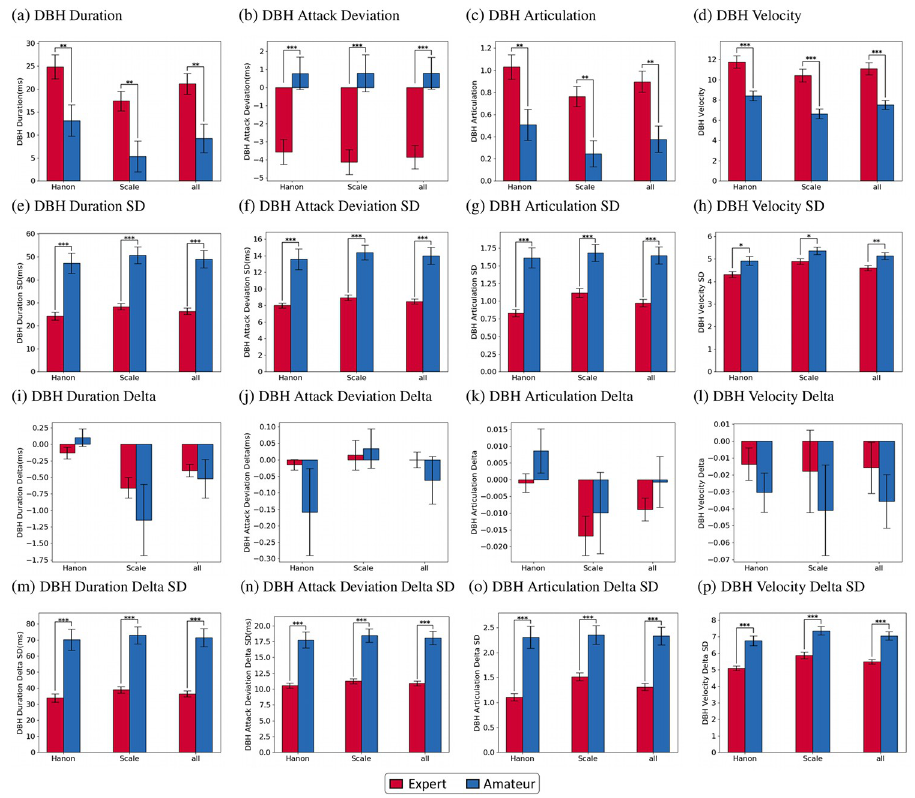
Fig 3. The bar plots with the results of the independent t-test for comparison of the DBH features. (a)-(d) The DBH features value of the mean; (e)-(h) the DBH features value of SD; (i)-(l) the DBH Delta features value of the mean; (m)-(p) the DBH Delta features value of SD. The DBH features were calculated as follows: right-hand notes—left-hand notes. A negative value indicates that the right hand tends to hit note(s) faster and for a shorter duration than the left hand when both hands play simultaneously, and a positive value indicates the opposite. Error bars represent standard errors (expert, red; amateur, blue). ��� p < .001, �� p < .01, � p < .05. https://doi.org/10.1371/journal.pone.0250299.g003 across the feature sets, the Basic + DBH group still revealed a greater mean F 1 score than the other feature sets, regardless of the number of the components, as shown in Table 7 (0.8760 for 10 components; 0.9281 for 20 components; 0.9135 for 40 components). Since the total number of the DBH features is 16, the DBH-only group is discarded in experiments with 20 and 40 components.